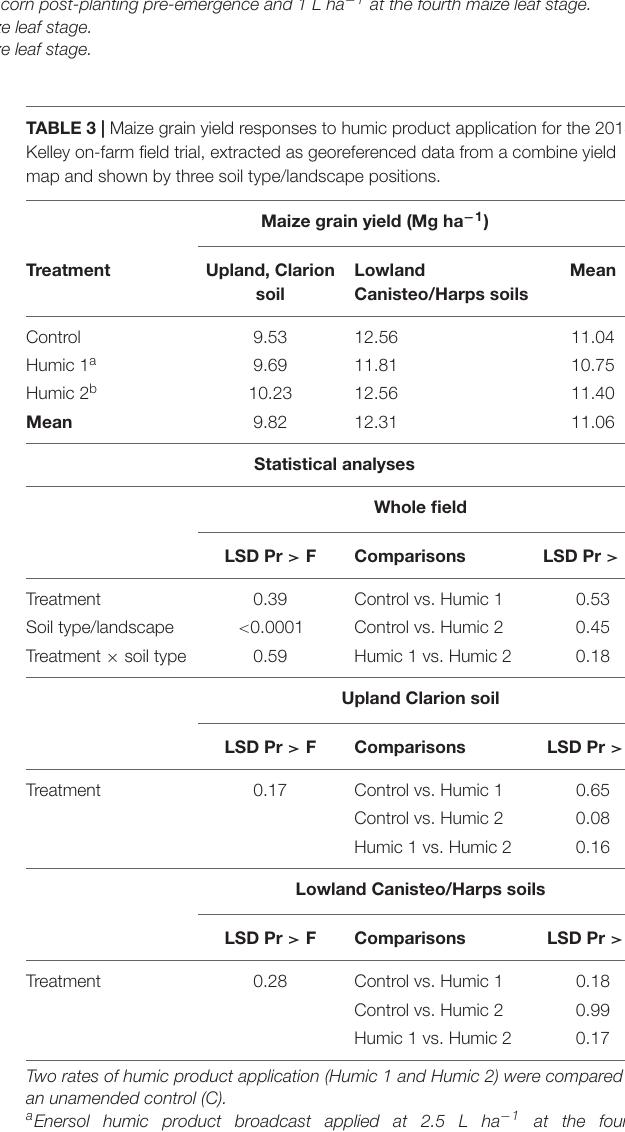
c Probability of statistical significance as determined by the Least Significance Difference